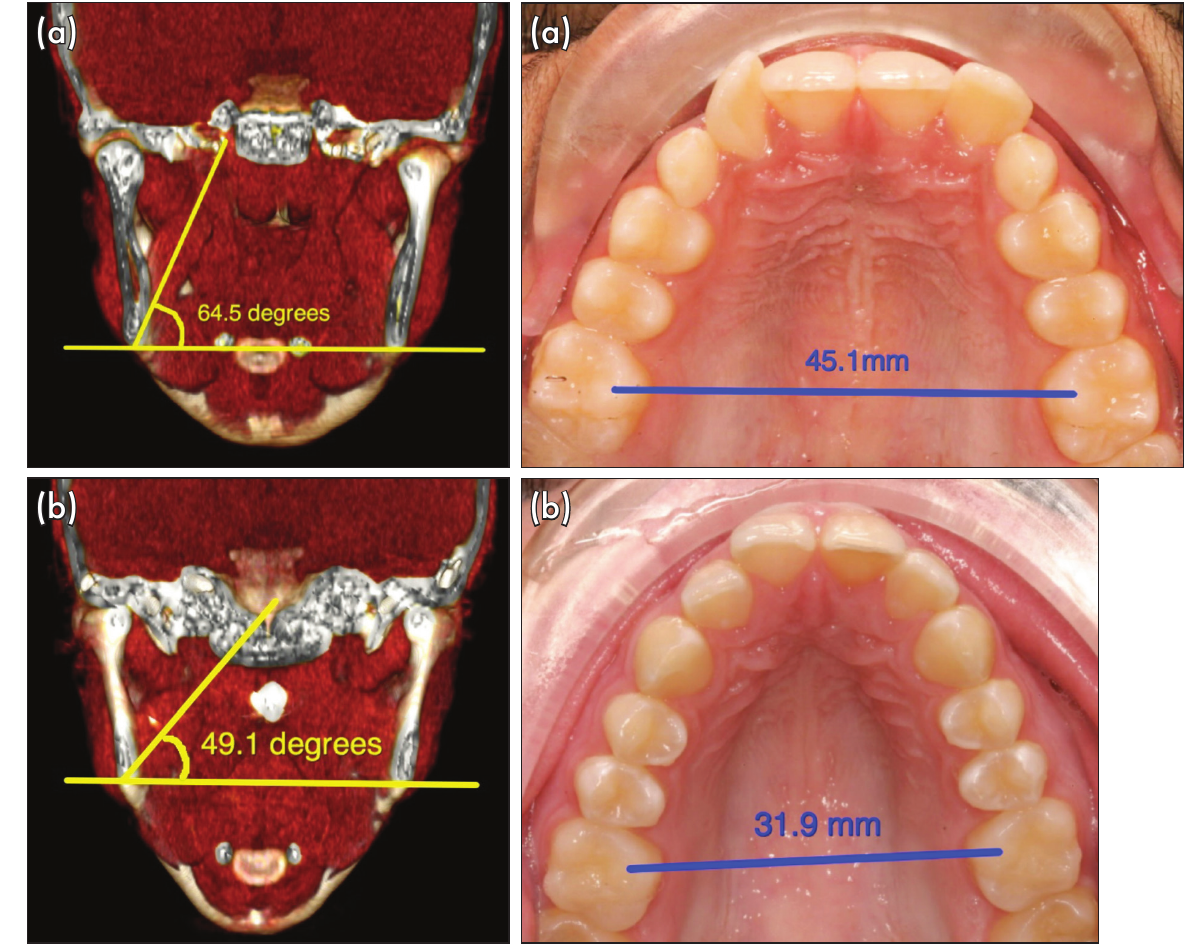
Figure 7. Extremes of maxillary intermolar width: (a) subject with larger medial pterygoid angle and larger maxillary arch width; (b) subject with relatively smaller medial pterygoid angle and smaller maxillary arch